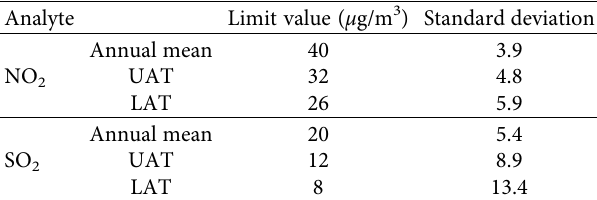
Table 3: Uncertainty in